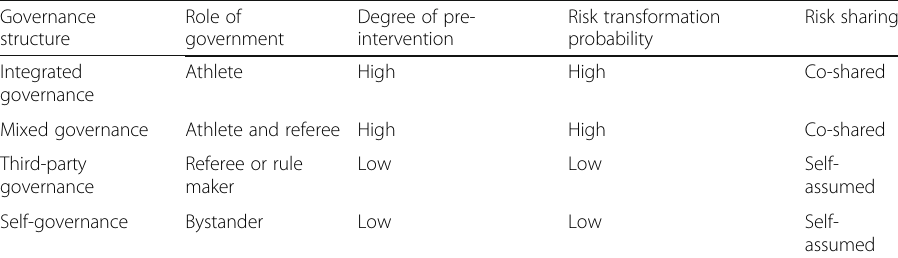
Table 1 The relationship between government and market players (governance